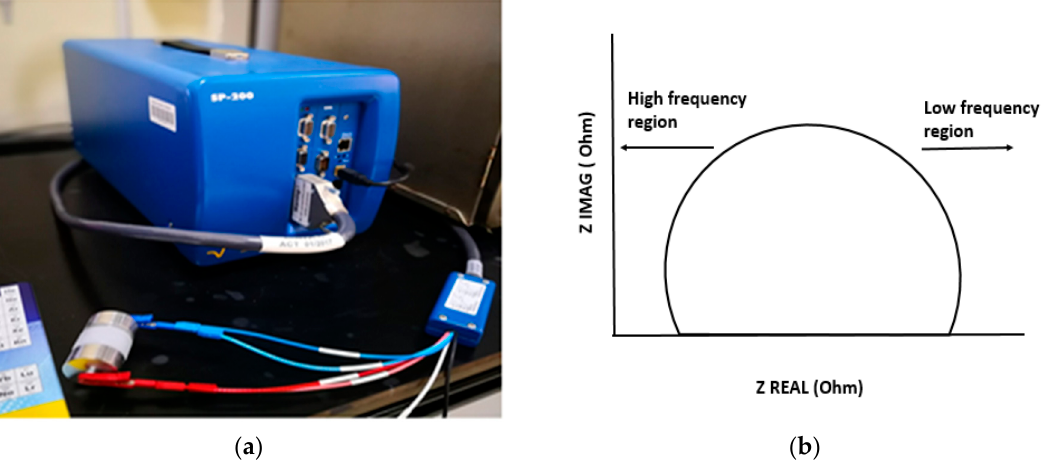
Figure 1. ( a ) The experimental setup used to measure the characterization of the samples and the output as a Nyquist plot, and ( b ) is one example of the Nyquist plot.